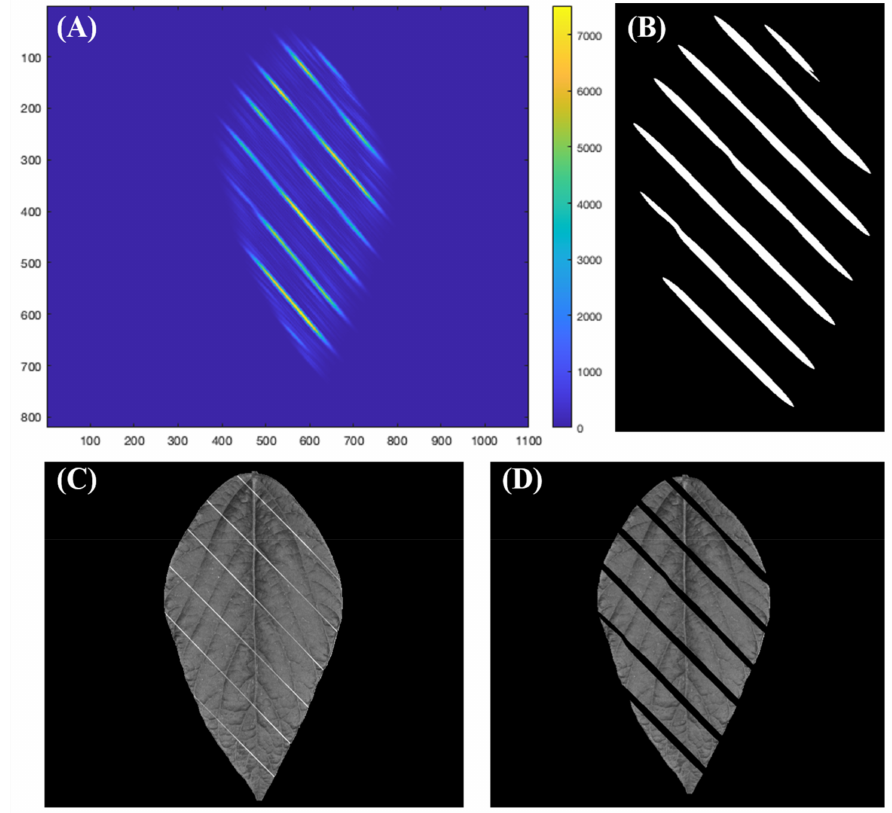
Figure 4. Segmentation procedure of nylon threads. ( A ) Magnitude map of Gabor filter recognizing aligned nylon threads. ( B ) Mask generated from the Gabor filter map. ( C ) Image before segmentation. ( D ) Image after